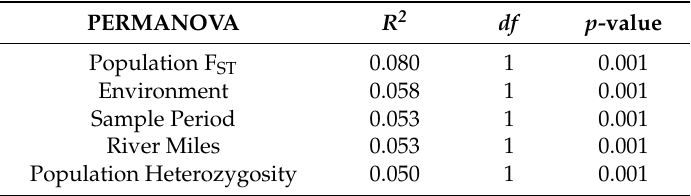
Table 5. PERMANOVA (in order of proportion explained) statistics